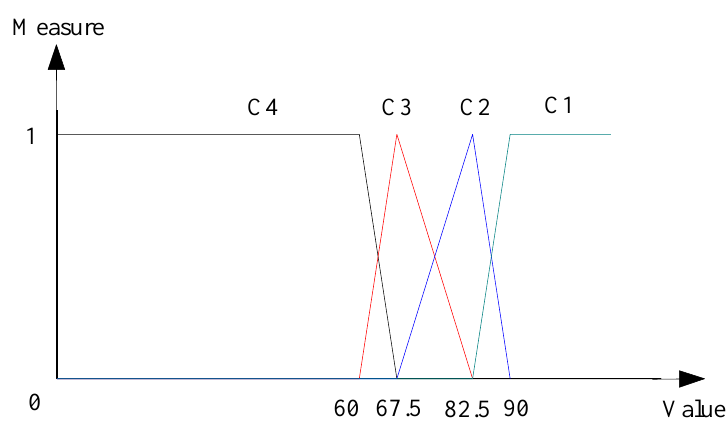
Figure 8. Unascertained measurement function.